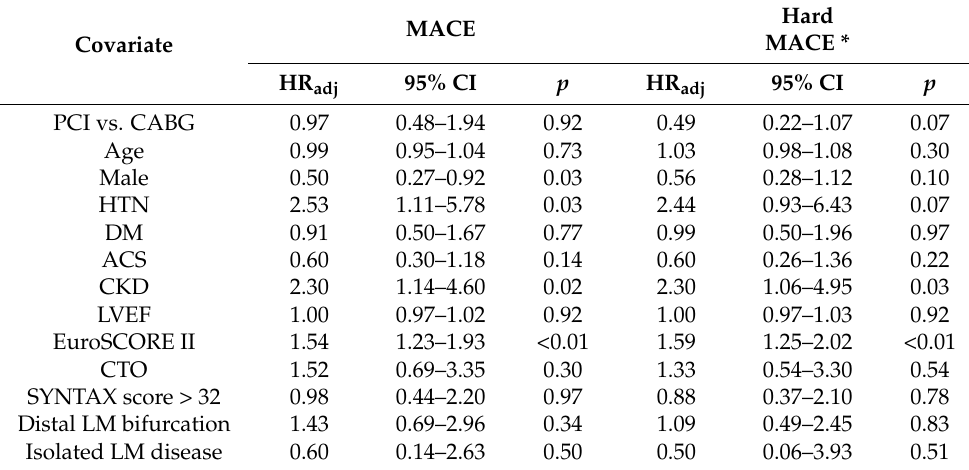
Table 4. Predictors for the composite outcomes in LM disease.